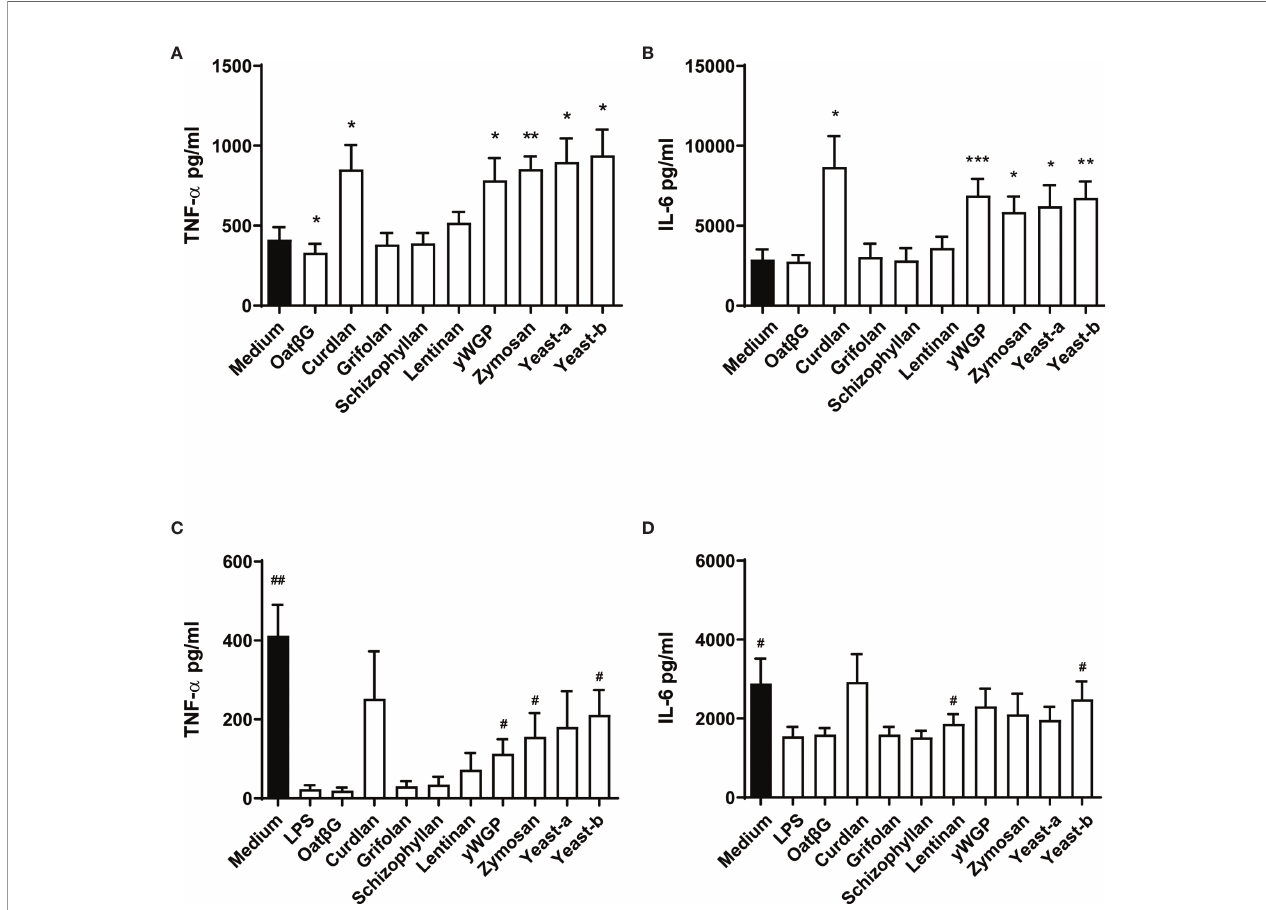
FIGURE 4 | Yeast-b, zymosan, curdlan, yWGP and yeast-a induced training and/or resilience in the macrophages model with continuous exposure. Monocytes were treated as depicted in Figure 3A . Monocytes were exposed to medium from days 1 to 6, or trained with 5 m g/ml b -glucans from days 2 to 6, before testing the training effect by challenging them with 10 ng/ml LPS at day 7 for 24 h (A, B) . Alternatively, to test induced resilience, monocytes were challenged with LPS at day 1, from days 2 to day 6 cells were cultured in medium or with 5 m g/ml b -glucans and challenged with 10 ng/ml LPS at day 7 for 24 h (C, D) . Supernatants of conditioned media were collected and TNF- a (A, C) and IL6 (B, D) measured by ELISA. Results are shown in a bar graph as average pg/ml cytokine ± SD of n =6 different donors. Data was analyzed with paired Student ’ s t test and statistical signi fi cances were indicated: *P < 0.05 compared to the no b -glucan (medium) control; **P < 0.01 compared to the medium control; # P < 0.05 compared to the LPS control. ***P < 0.001 compared to the medium